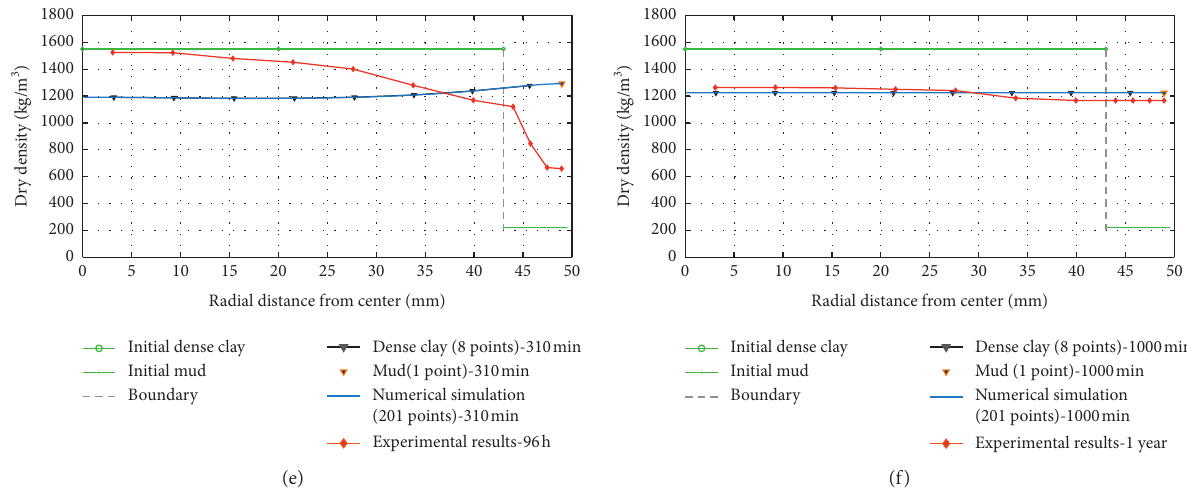
Figure 8: Comparison of clay maturation in numerical modelling and laboratory experiments. In Figure 8(f), the simulation results of 1000 minutes were used for comparison since end of maturation was reached. (a) Maturation with 6h (experiment), 8min (simulation). (b) Maturation with 12 h (experiment), 20min (simulation). (c) Maturation with 24h (experiment), 50min (simulation). (d) Maturation with 48h (experiment), 125min (simulation). (e) Maturation with 96h (experiment), 310min (simulation). (f) Maturation with 1 year (ex- periment), 1000min